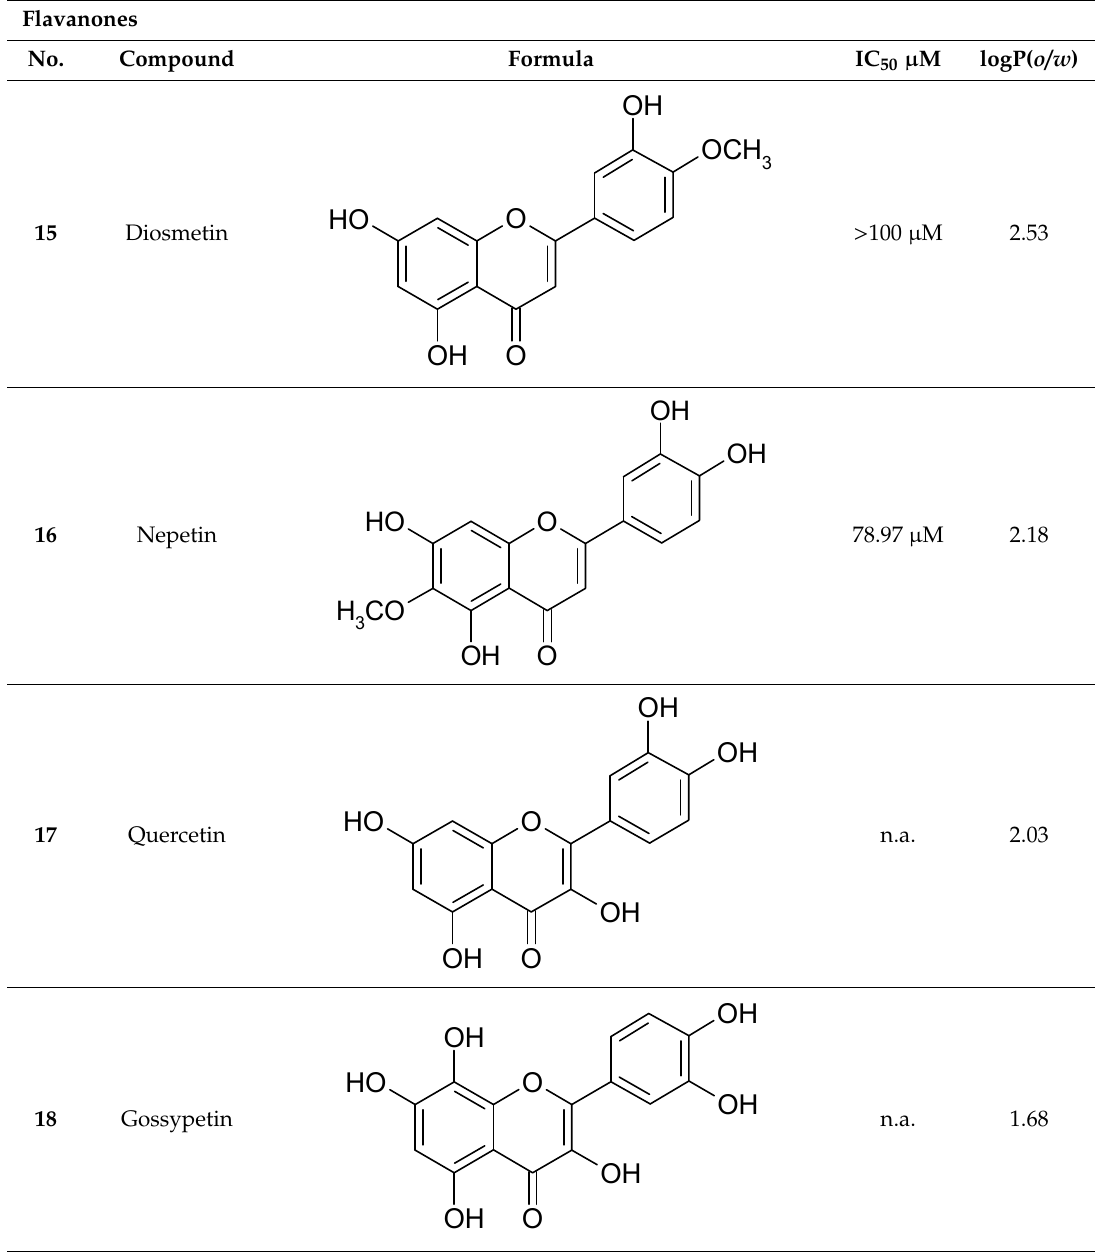
Figure S2b), an irreversible inhibitor of I- κ B α phosphorylation and of CCID formation [2], for which an IC 50 of 7.2 µ M was